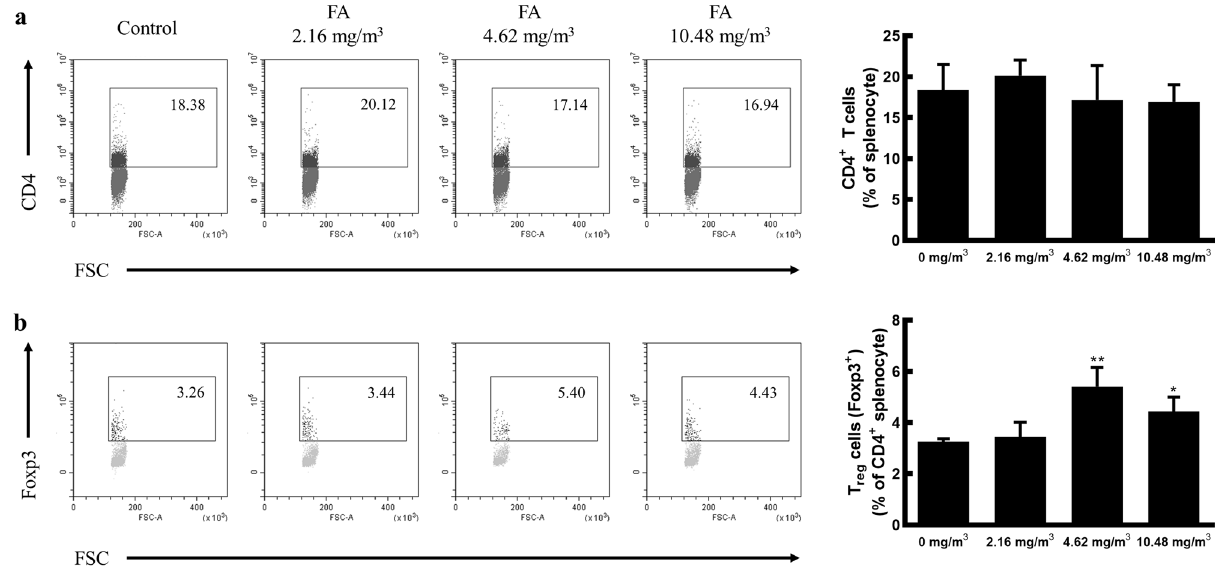
Figure 3. Regulation of the CD4 + T cell and Treg cell populations by FA exposure. Single spleen cells isolated from minipigs exposed to FA were stained with PerCP-Cy™5.5-conjugated anti-CD4 and FITC-conjugated anti- Foxp3 monoclonal antibodies. The fluorescence levels were measured using a CytoFlex flow cytometer. ( a ) CD4 + T cell population in single spleen cells. ( b ) CD4 + Foxp3 + Treg cell population in CD4 + T cells. Data are shown as representative dot plots and presented as the mean ± SD from two independent experiments ( n = 2 minipigs/ group). * p < 0.05, ** p < 0.01. FA formaldehyde.